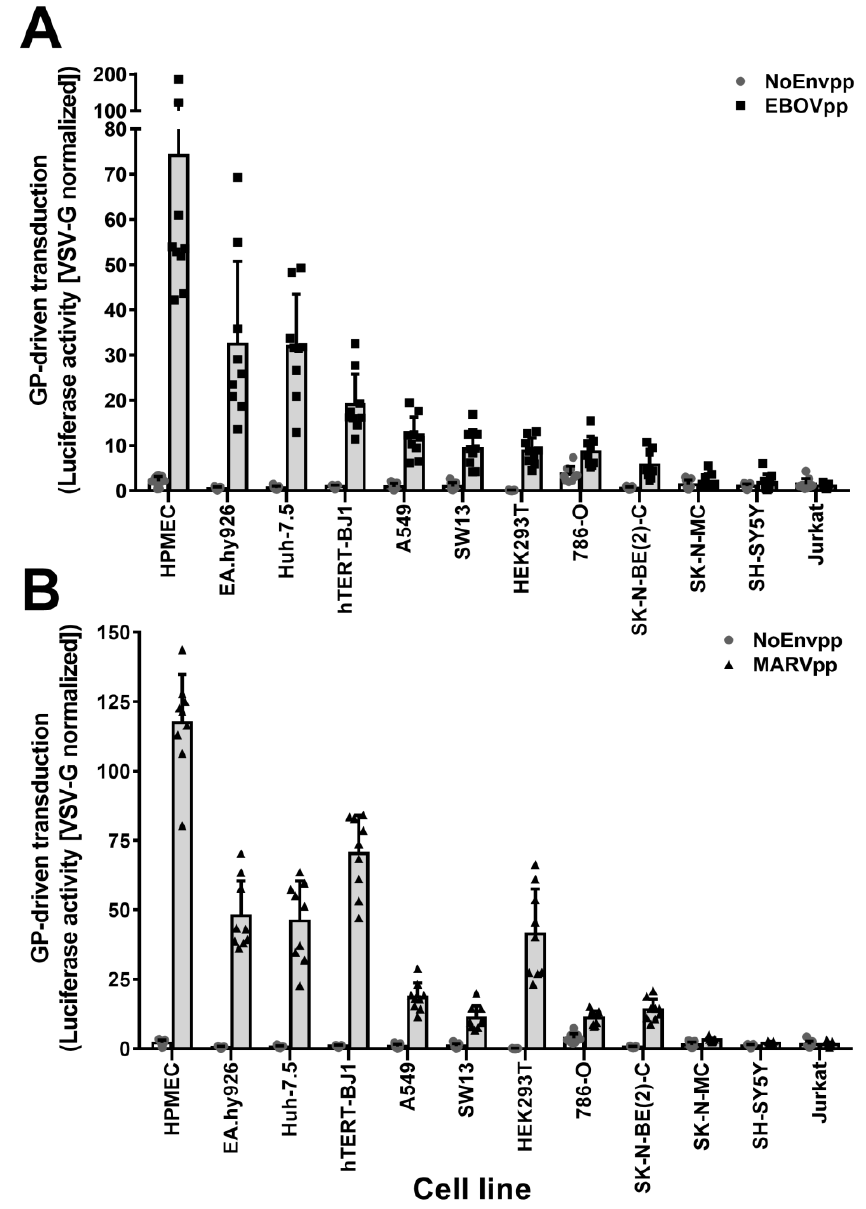
Figure 1. Unbiased cell screening for susceptibility to EBOV (EBOVpp) and MARV (MARVpp) GP-driven transduction. A panel of twelve cell lines were transduced with EBOV ( A ) or MARV ( B ) firefly luciferase pseudoparticles. Pseudoparticles with no envelope proteins (NoEnvpp) or